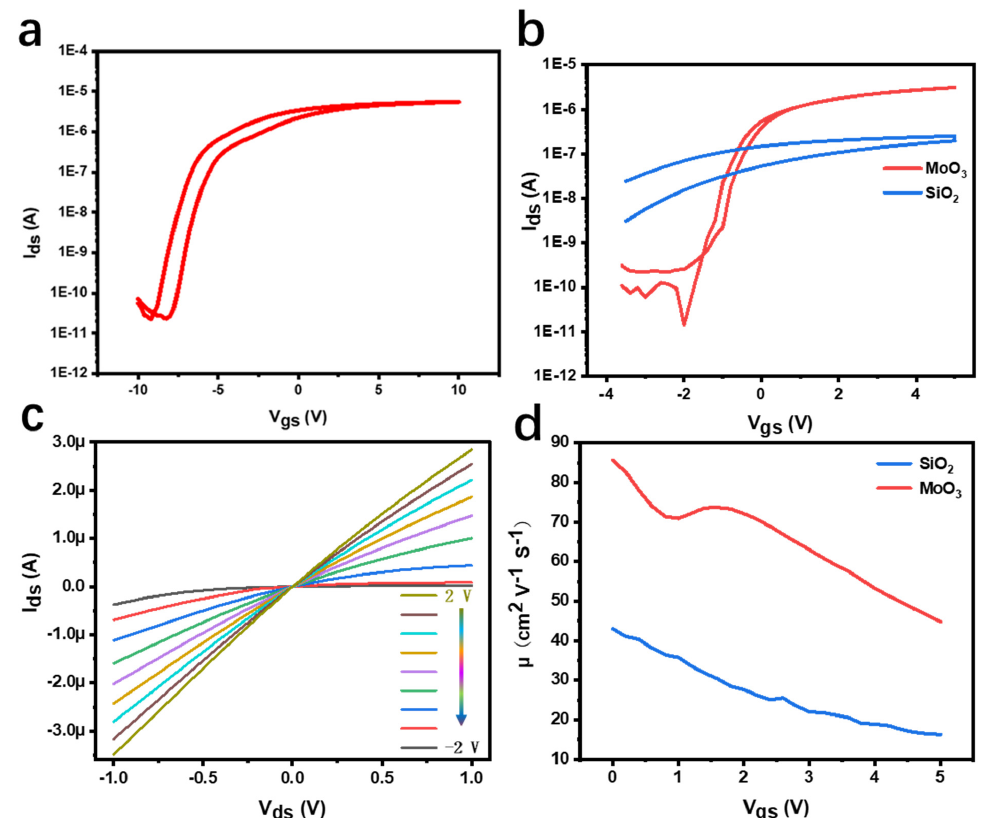
Figure 3. ( a ) Transfer curves of the gate of SiO 2 under more gate voltage range. ( b ) Comparison of transfer curves of different substrates under the same gate voltage range. ( c ) Output curves of the device, the interval is 0.5 V. ( d ) The relationship between the mobility of different substrates and gate voltage curve. Table 1. Device data for different gate dielectric